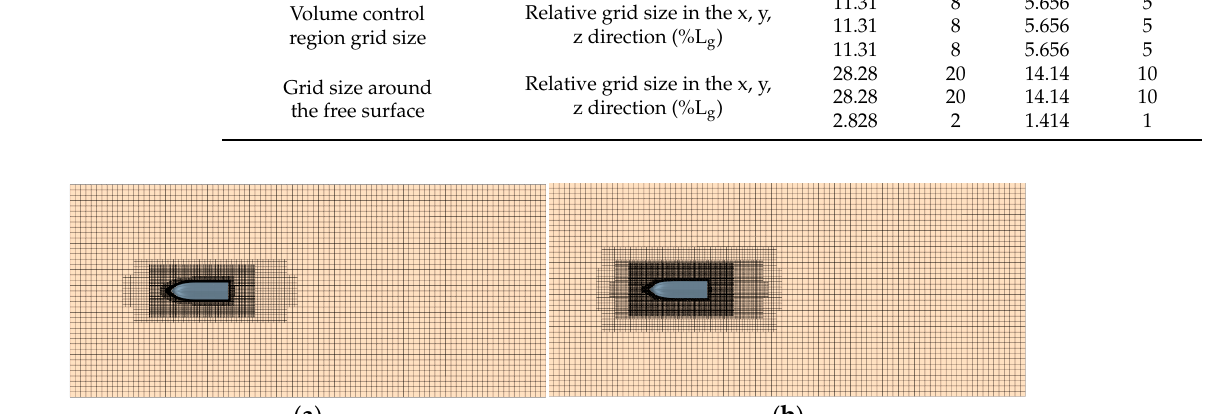
Table 3. Parameters of the four grids.